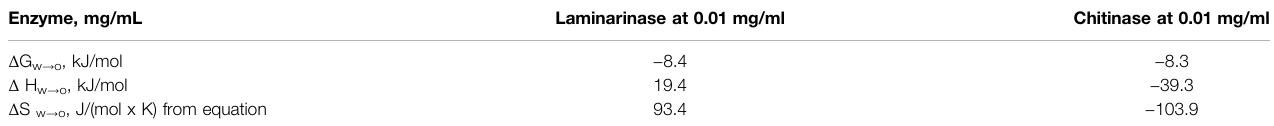
TABLE 2 | Thermodinamic parameters (free energy, enthalpy and entropy) for the transfer of enzymes (laminarinase and chitinase) from aqueous media to soybean lecithin liposomes (Cano-Salazar et al., 2011). Enzyme, mg/mL